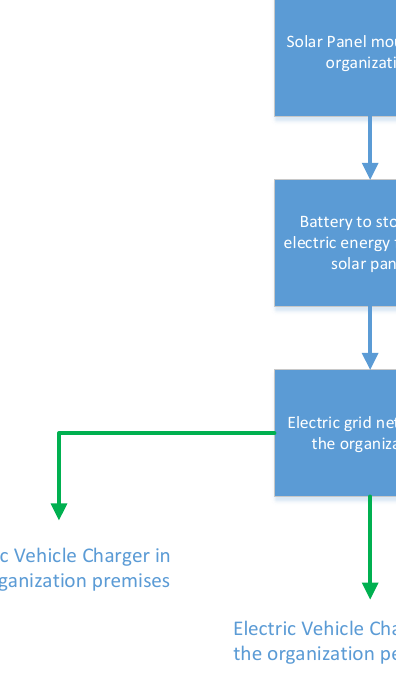
Figure 8. Solar panel and charging system for household